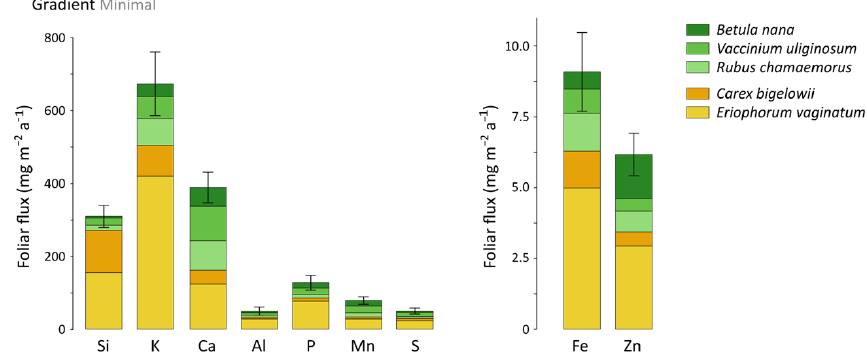
Figure 9. Cumulative annual foliar fluxes (mgm − 2 a − 1 ) of mineral elements for the considered plant species at the least degraded area (Minimal) of the thermokarst gradient (Gradient) in 2017. Vegetation is sorted by plant functional types: deciduous shrubs and forbs (green) and sedges (yellow). Error bars represent standard deviations.